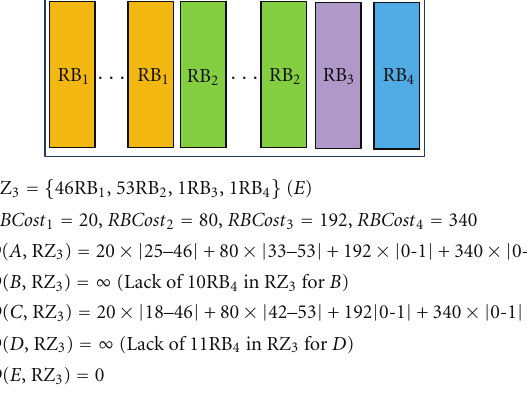
Figure 6: Example of computing cost D with RZ 3